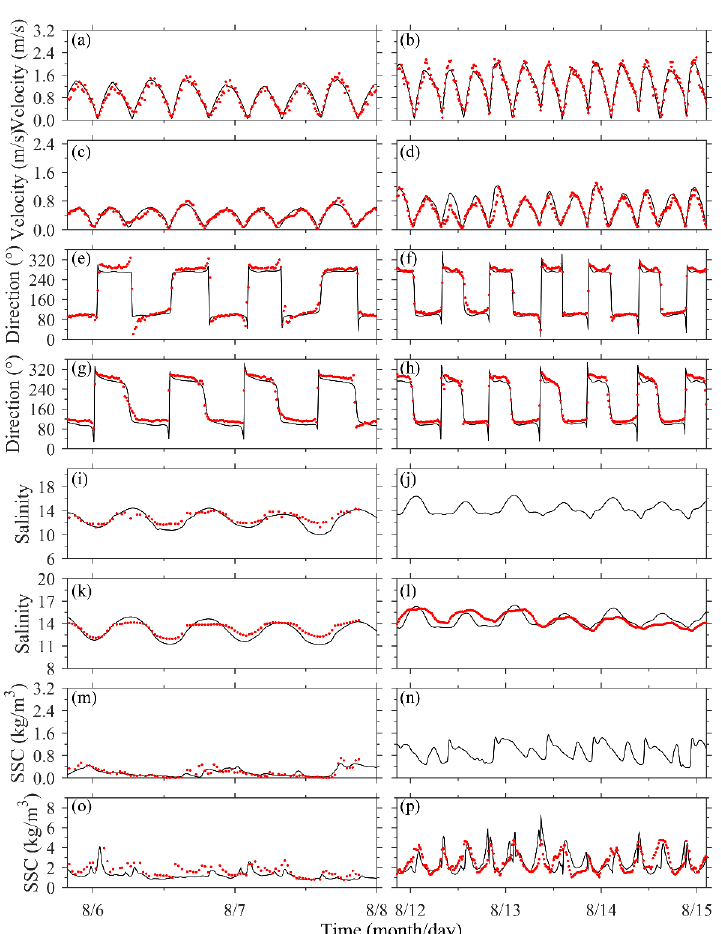
Figure 5. Comparisons between the observed data (red dots) and simulated results (black line) at measured site B. The left column represents neap tide, and the right column represents spring tide. ( a , b ) Surface velocity; ( c , d ) bottom velocity; ( e , f ) surface direction; ( g , h ) bottom direction; ( i , j ) surface salinity; ( k , l ) bottom salinity; ( m , n ) surface SSC; and ( o , p ) bottom SSC (loss of surface SSC during spring tide due to the typhoon). Table 2. Correlation coefficients (CC), root-mean-square error (RMSE), and skill scores (SS) for com- parison of modeled and observed water velocity, salinity, and suspended sediment at the measuring stations.